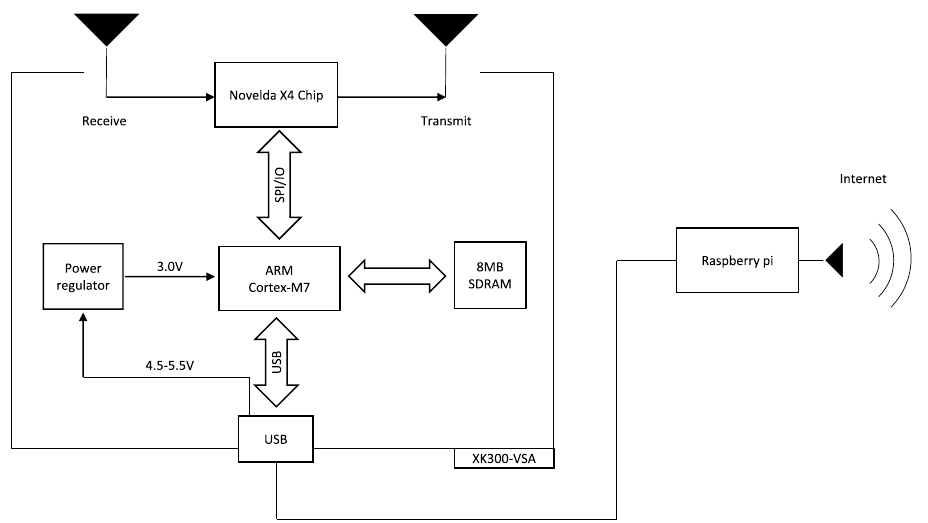
Figure 2. Hardware diagram of XK300-VSA. The ARM Cortex-M7 controls the radar chip to transmit and receive the radar signal and then computes the RR, HR and relative movement index. After the whole procedure, RR, HR and relative movement index are transmitted to the Raspberry pi through USB to be sent to the server for